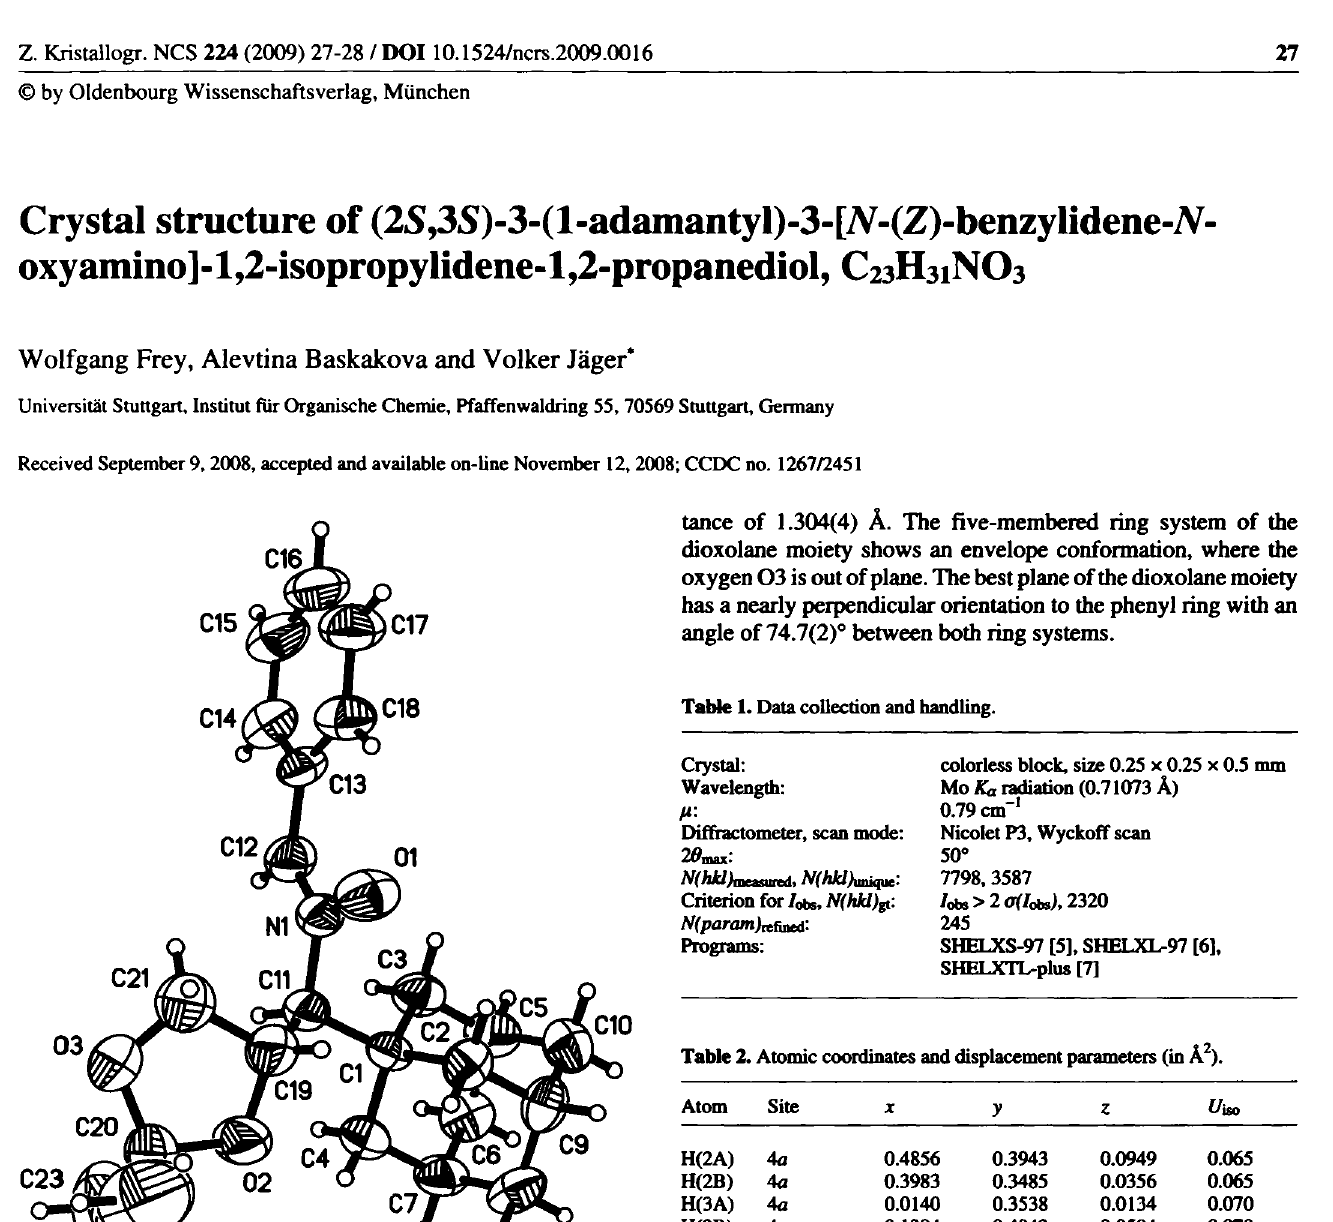
Table 2. Atomic coordinates and displacement parameters (in Â 2